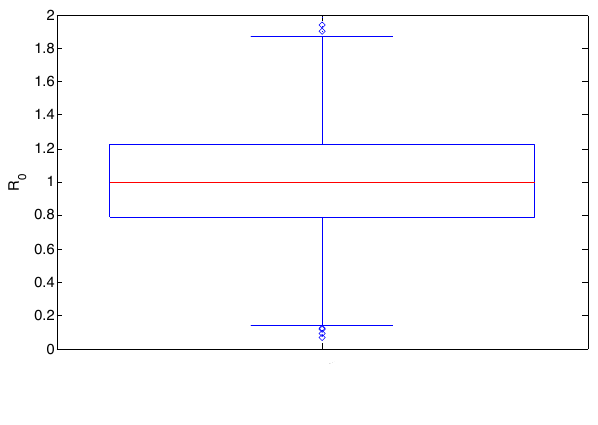
Figure 9. Box plot of distribution of R ranges in Table 1 with m = 1 . The median value of R small variations in parameters can result in either viral persistence or